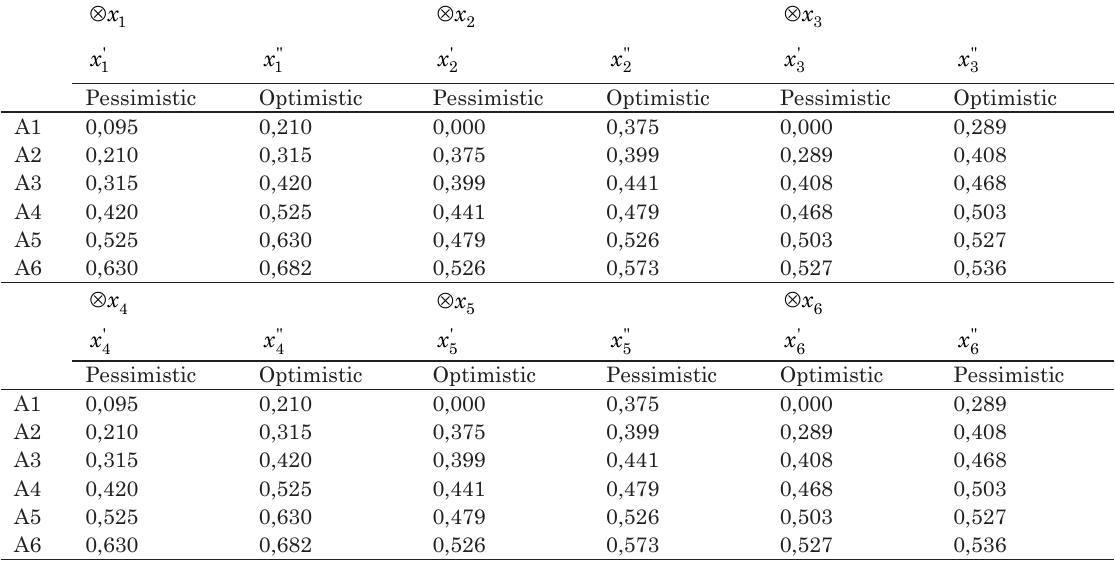
Table 4. Normalized decision-making matrix